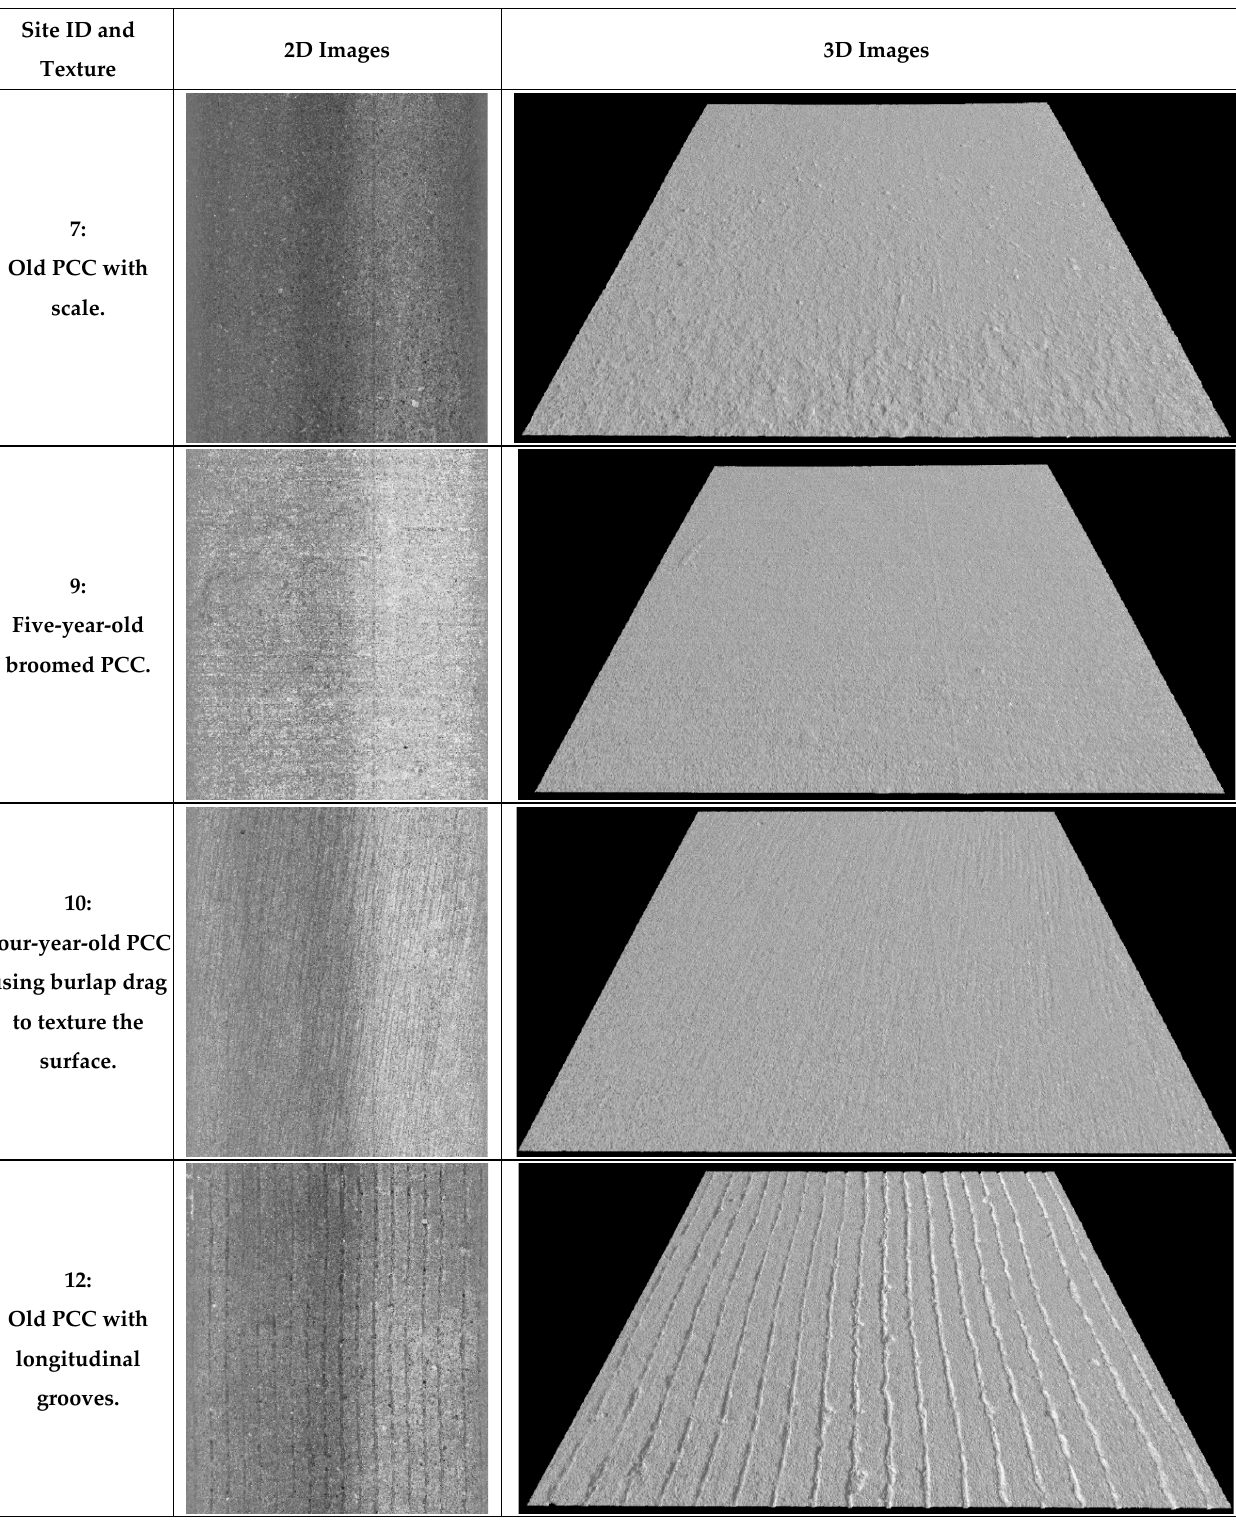
Figure 4. Example 0.1 mm images on PCC sites.